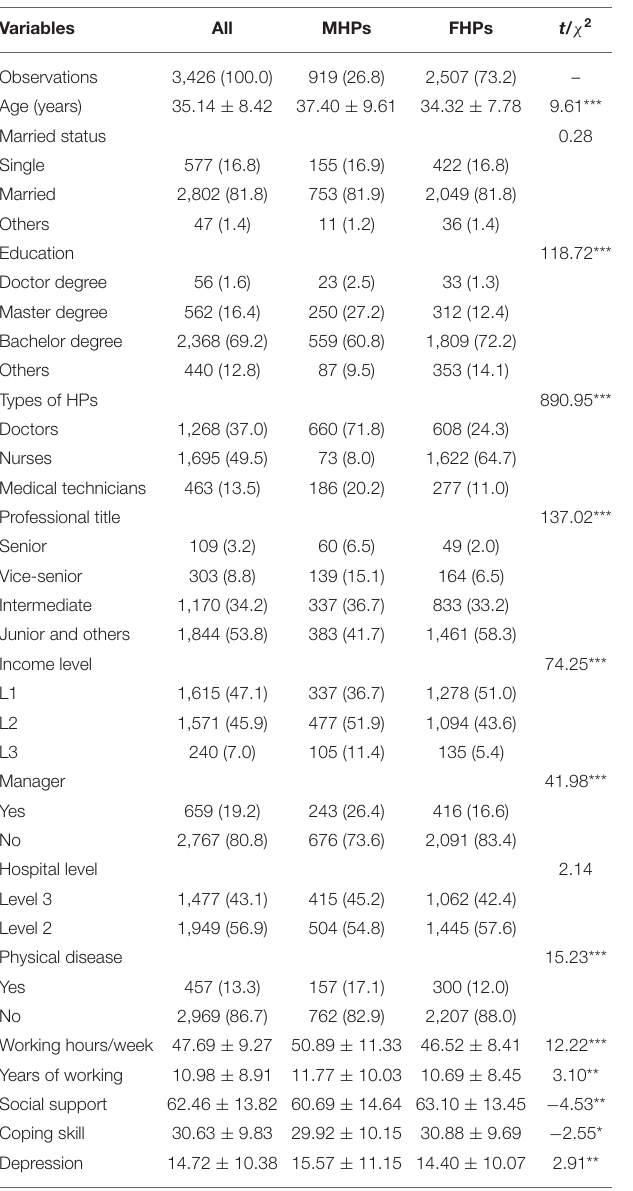
TABLE 1 | Sample description and single analyses for gender differences in the sample [ n (%)].